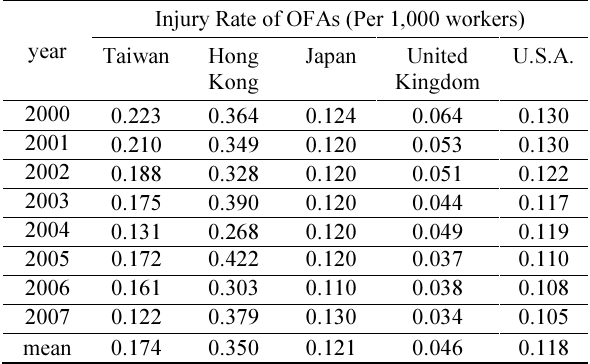
Table 1. Occupational fatalities in the construction industry